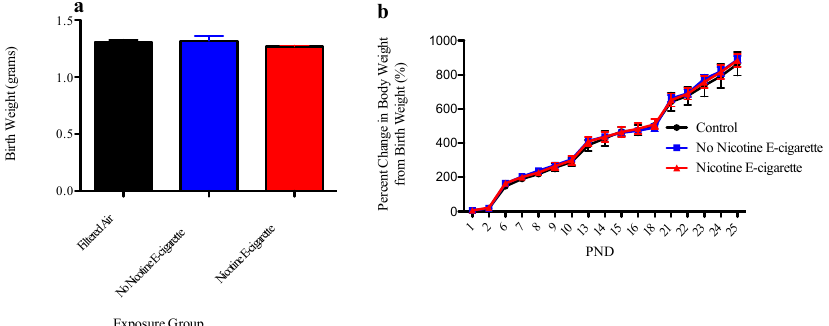
Figure 1. The effect of e-cigarettes on birth weight and weight gain. ( a ) Data represent average litter birth weights ( n = 5–7 litters) ± SEM. Data were analyzed using a one-way ANOVA and Bonferroni post-hoc testing and data were not found to be significantly different from each other ( F -value: 1.2, degrees of freedom: 2). ( b ) Data represent average litter weight gain ( n = 3–5 litters) ± SEM. Data were analyzed using a two-way ANOVA and Bonferroni post hoc testing and were not found to be significantly different from each other ( F -value: 0.91, degrees of freedom: 2).